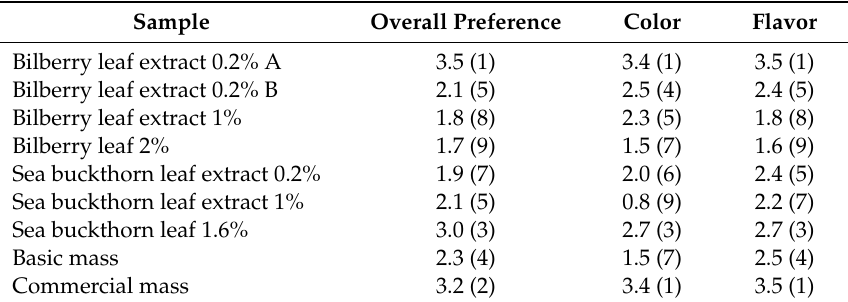
Table 3. Medians of preference scores (rank) of sausages ( n = 10).